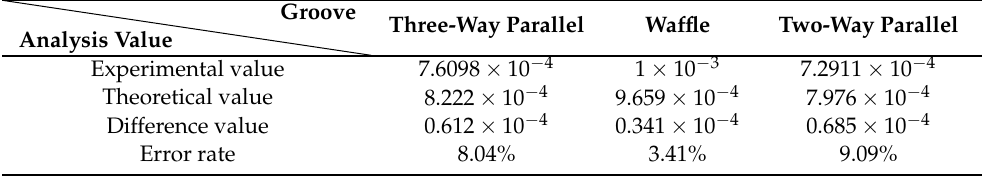
Table 6. Comparison of the theoretical wear depth and experimental wear depth (unit: mm). Groove Three-Way Parallel Waffle Two-Way Parallel Analysis Value Experimental value 7.6098 × 10 − 4 1 × 10 − 3 7.2911 × 10 − 4 Theoretical value 8.222 × 10 − 4 9.659 × 10 − 4 7.976 × 10 − 4 Difference value 0.612 × 10 − 4 0.341 × 10 − 4 0.685 × 10 − 4 Error rate 3.41%